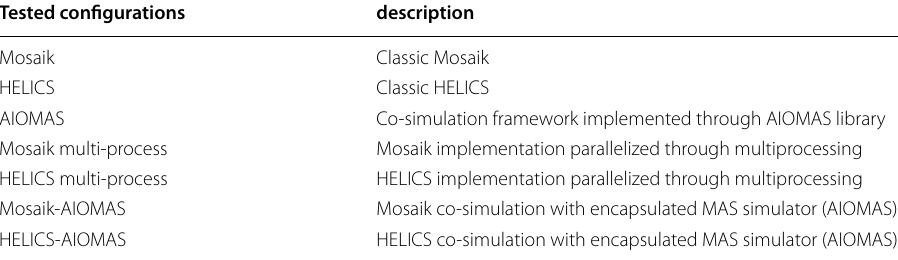
Table 1 Summary of the tested configurations Tested configurations